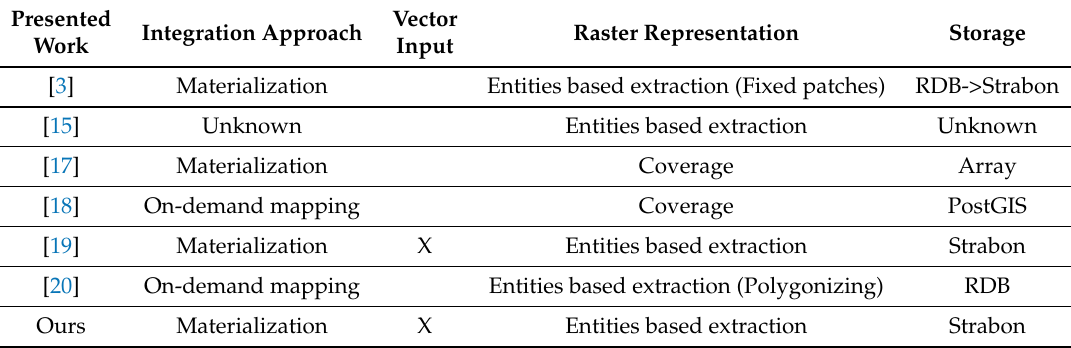
Table 2. Comparison of raster integration/representation